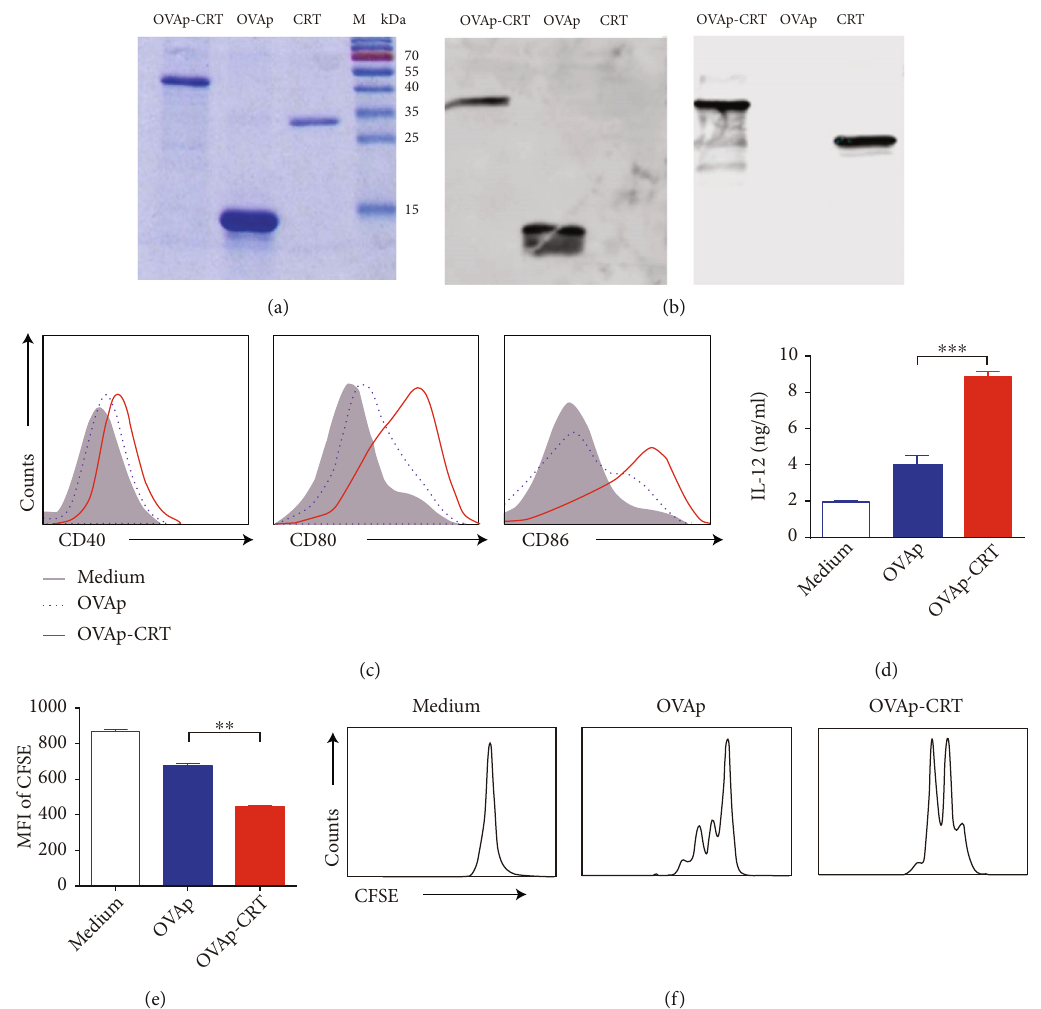
Figure 1: Expression and puri fi cation of recombinant proteins and CRT/39-272 promote DC function in vitro . (a) A ffi nity-puri fi ed OVAp- CRT (lane 1), OVAp (lane 2), and CRT/39-272 (lane 3) were run in three identical 10% SDS-PAGs. One gel was stained with Coomassie blue. Protein molecular mass markers (M) were loaded in the right lane. (b) Protein bands in the two unstained gels were transferred to PVDF membranes for western blotting with mouse anti-CRT monoclonal antibodies (left) and rabbit anti-OVA polyclonal antibodies (right). (c) Immature BMDCs were stimulated with OVAp or OVAp-CRT for 24 h. The generated DCs, DC-OVAp, and DC-OVAp- CRT were stained with PE-conjugated anti-CD40, anti-CD80, and anti-CD86. (d) IL-12 levels in the supernatants of cultured DCs, DC- OVAp, and DC-OVAp-CRT were analyzed by ELISA. (e and f) BMDCs were incubated with CFSE-labeled pan T cells from OT-I mice at a 1 :10 ratio in the presence of medium, OVAp, or OVAp-CRT for 3 days. The mean fl uorescence intensity (MFI) of the CFSE was analyzed (e) and fl uorescence-activated cell sorting (FACS) histograms are shown (f). The results were replicated three times with a consistent trend. Data are representative of at least three independent experiments. ∗∗ p < 0 : 01 . ∗∗∗ p < 0 : 001